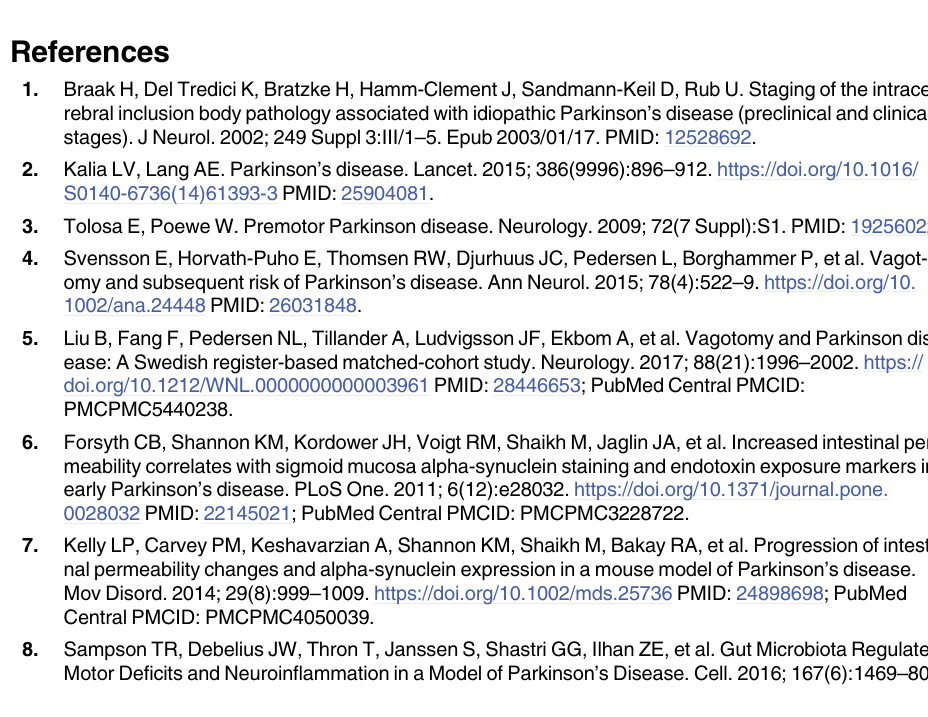
S3 Table. Phylogenetic distribution of hydrogenase genes in representative human gut strains analyzed by YIF-Scan. S4 Table. Raw data obtained in the current